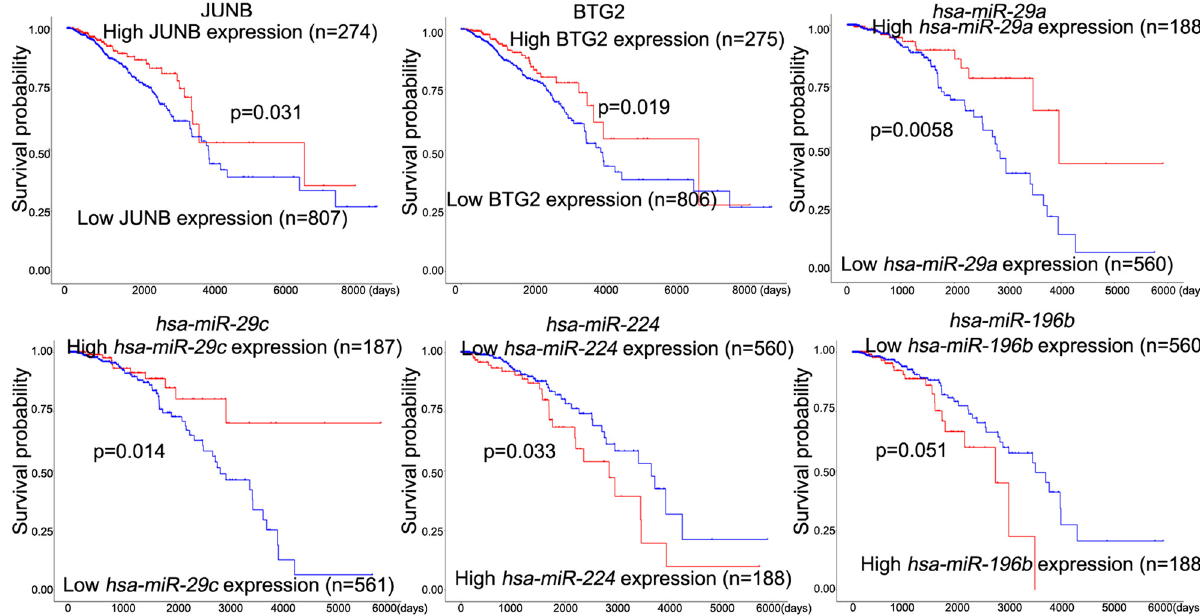
Figure 4: The survival analysis of genes and miRNAs in the miRNA – target regulatory network. Survival analysis was performed using the UALCAN online tool and based on the TCGA cohort ( breast invasive carcinoma ) .